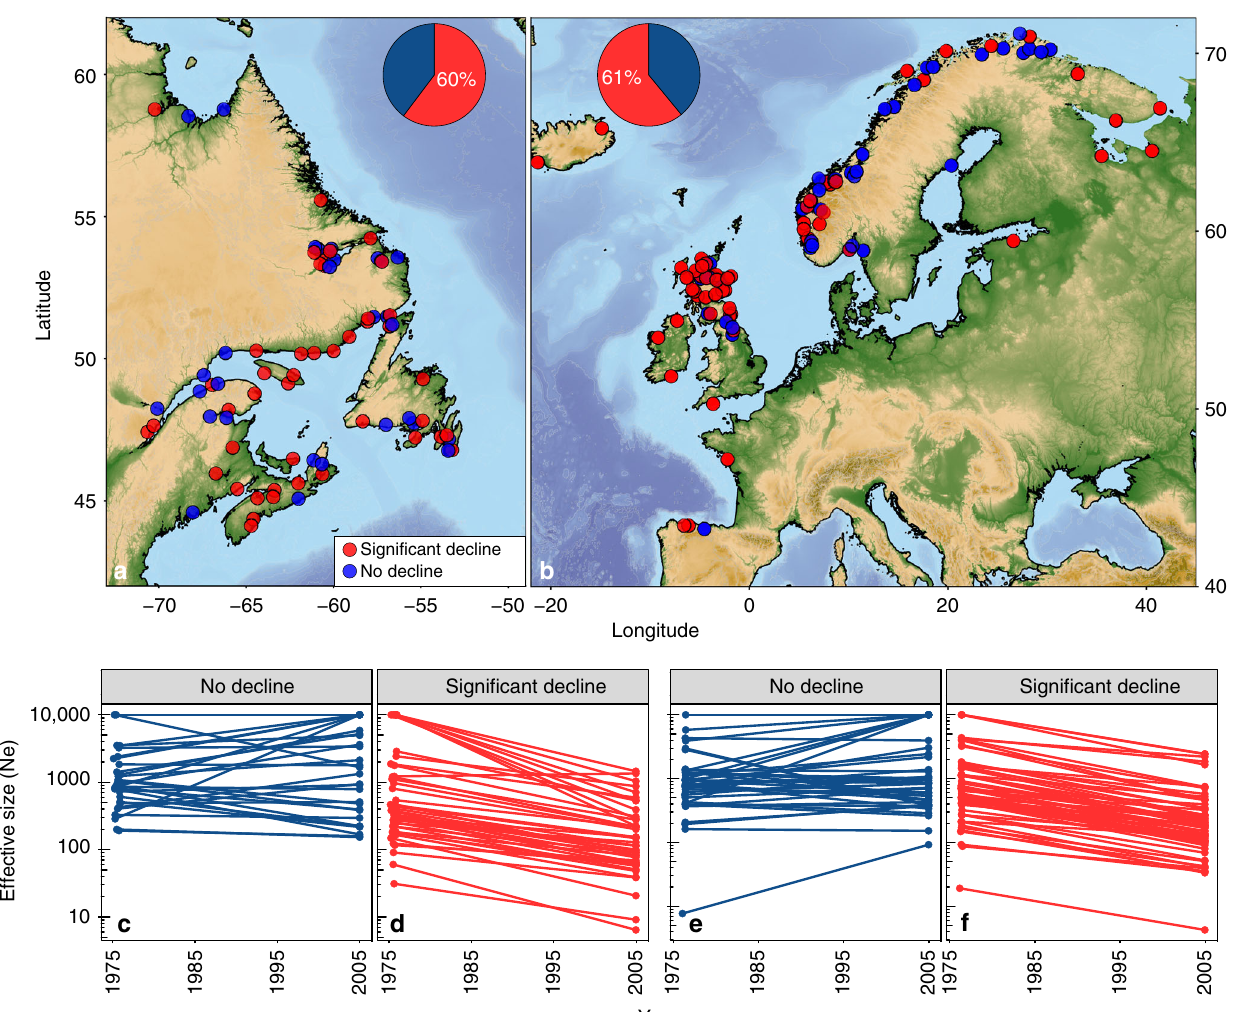
Fig. 1 Changes in effective population size ( N e ) of Atlantic salmon across the range. Map of all salmon sampling locations in ( a ) North America ( n = 73) and ( b ) Europe ( n = 99) with signi fi cantly declining (red) and non-declining (blue) populations indicated by coloured points. Inset pie chart shows the proportion of populations assigned to each category, with panels ( c – f ) showing changes in N e between 1975 and 2005 for non-declining ( c , North America; e , Europe) and signi fi cantly declining ( d , North America; f , Europe) populations. Any N e estimates with large or negative (in fi nite) values were converted to 10,000 for this fi gure. Maps were generated using National Oceanic and Atmospheric Administration (NOAA) bathymetry data from the R package marmap